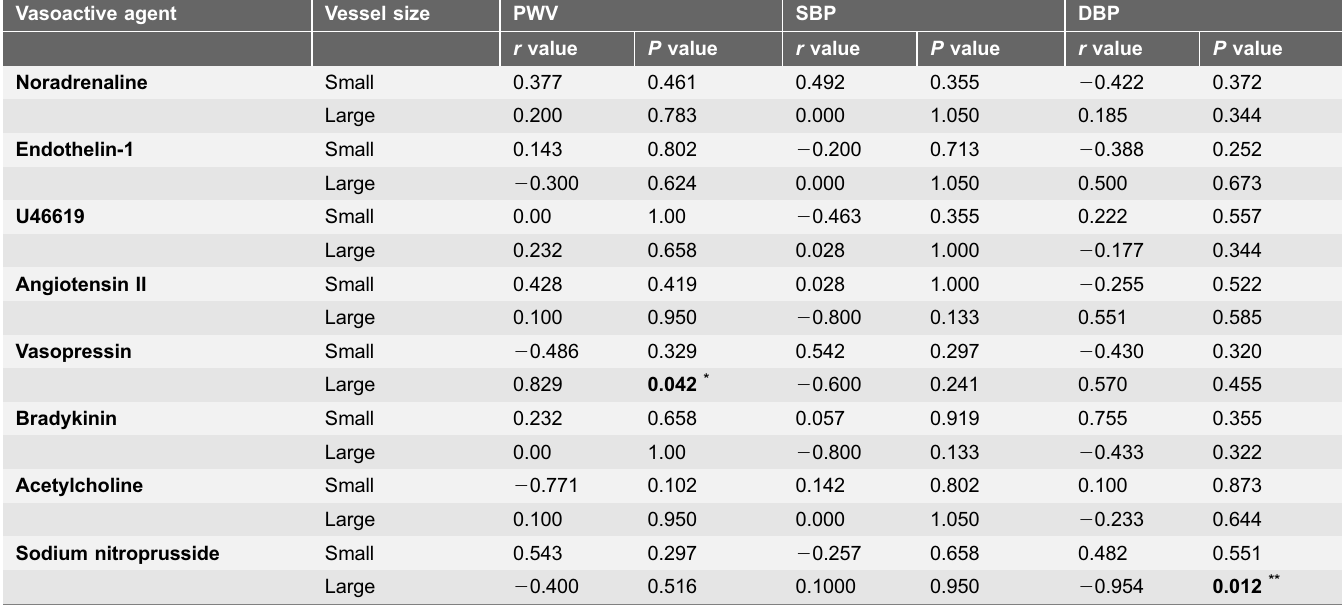
Table 2. Correlations of in vivo cardiovascular data with ex vivo vasoactive responses of arteries obtained from HD patients to different stimuli. Vasoactive